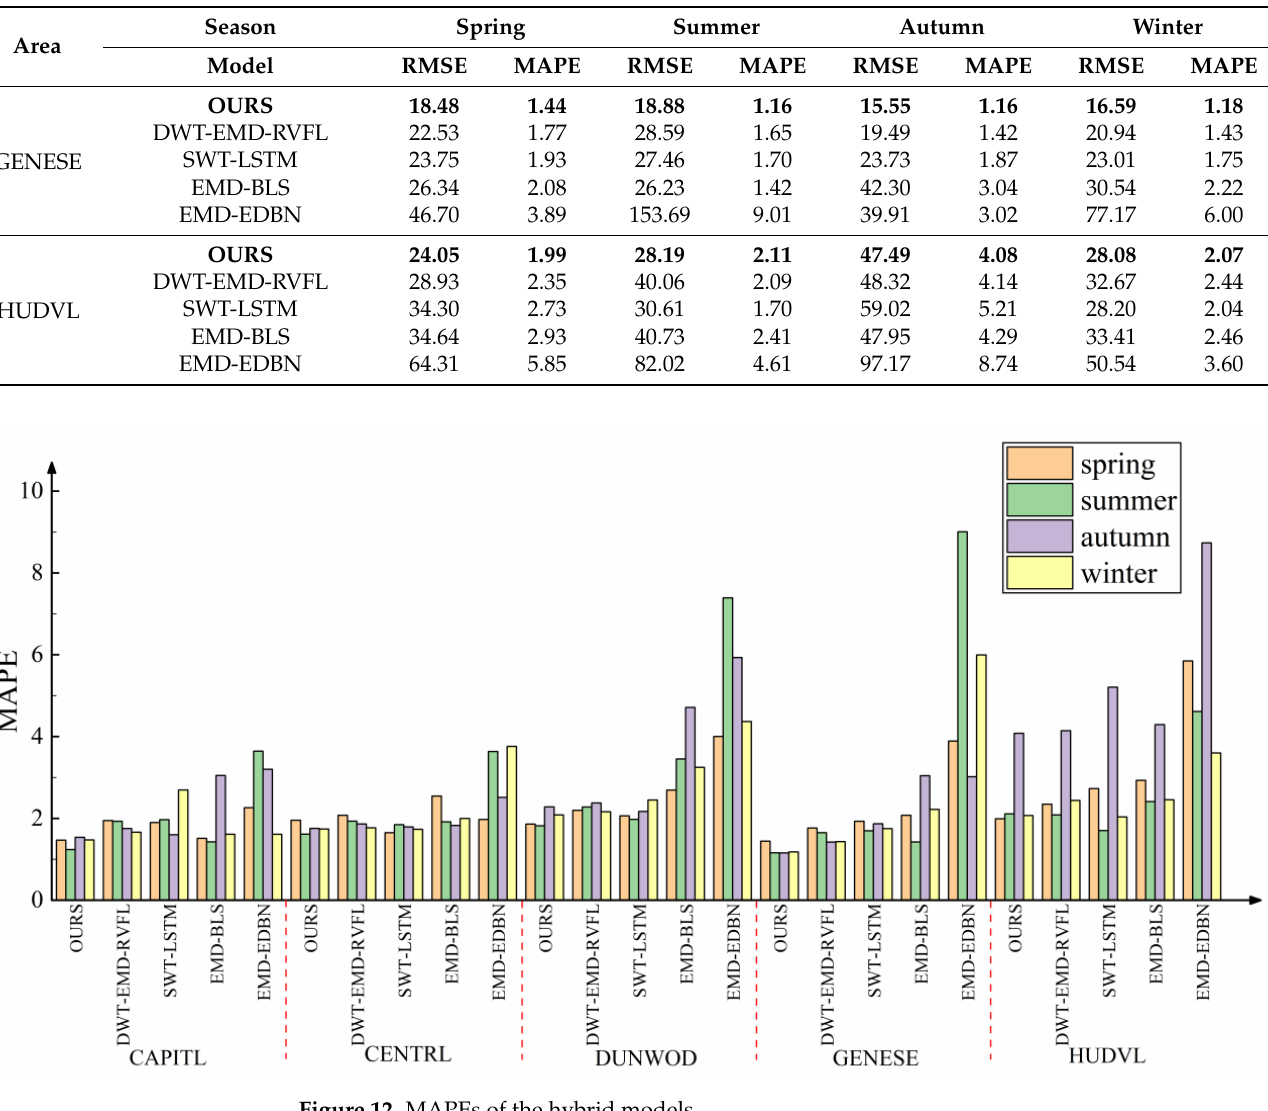
Figure 12. MAPEs of the hybrid models.